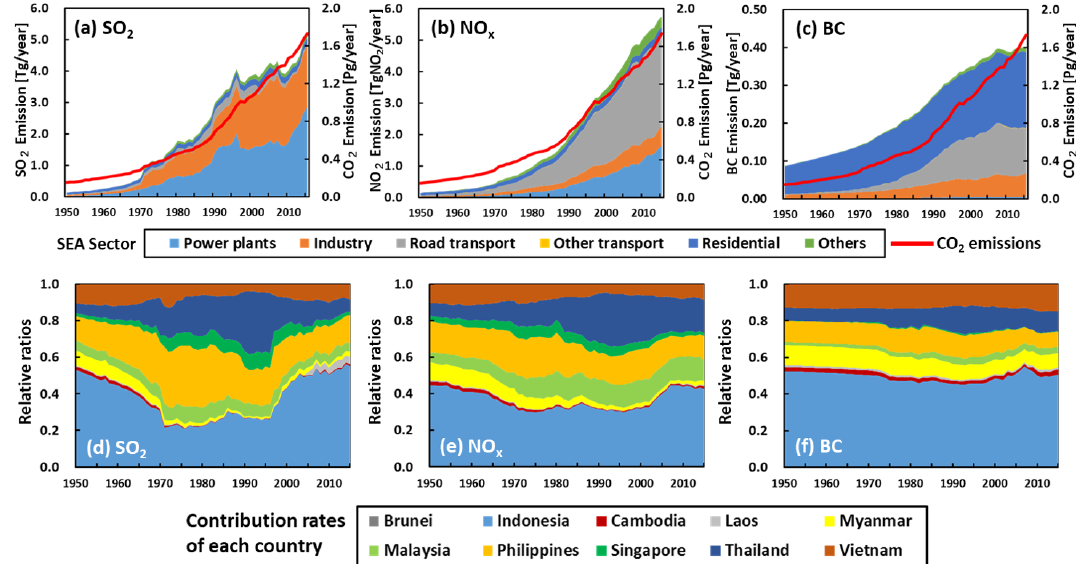
Figure 6. Emissions of (a) SO 2 , (b) NO x , and (c) BC from each major sector in SEA (a, b, c) and (d, e, f) relative ratios of emissions from each country in SEA (d, e, f) during 1950–2015. Red lines in the upper panels are total CO 2 emissions.